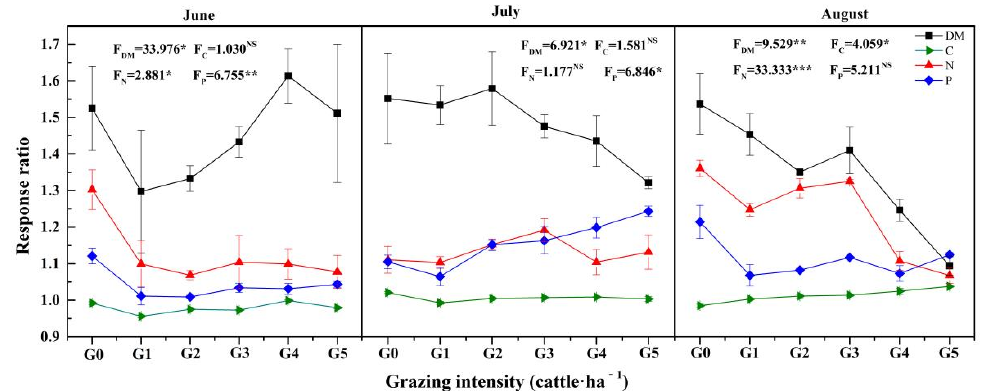
Figure 6. The differences of dry matter (DM), carbon (C), nitrogen (N), and phosphorus (P) contents response ratios between non-infected and rust-infected Leymus chinensis under different grazing intensities. Significant differences among grazing intensities are reported from ANOVA as ***, p <